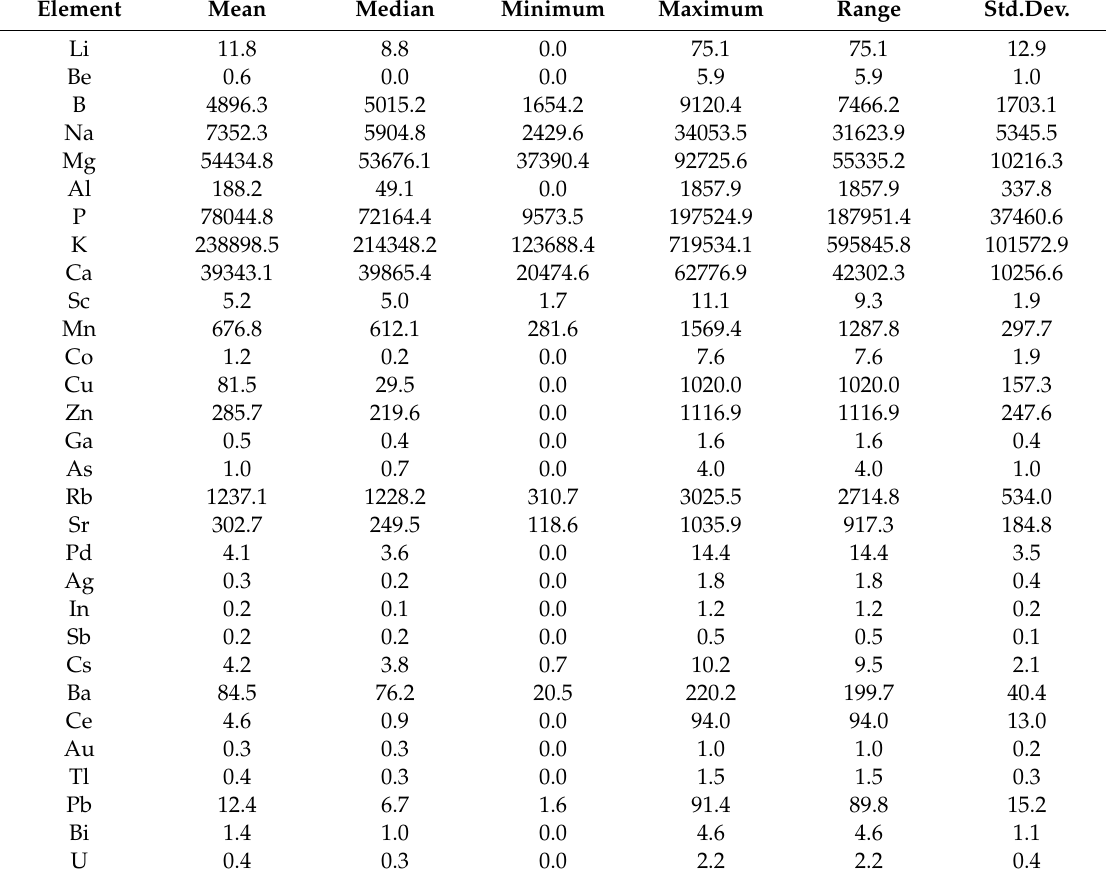
Table 1. Descriptive statistics of the concentration ( µ g · L − 1 ) of 30 elements, for investigated Romanian white wines ( n =